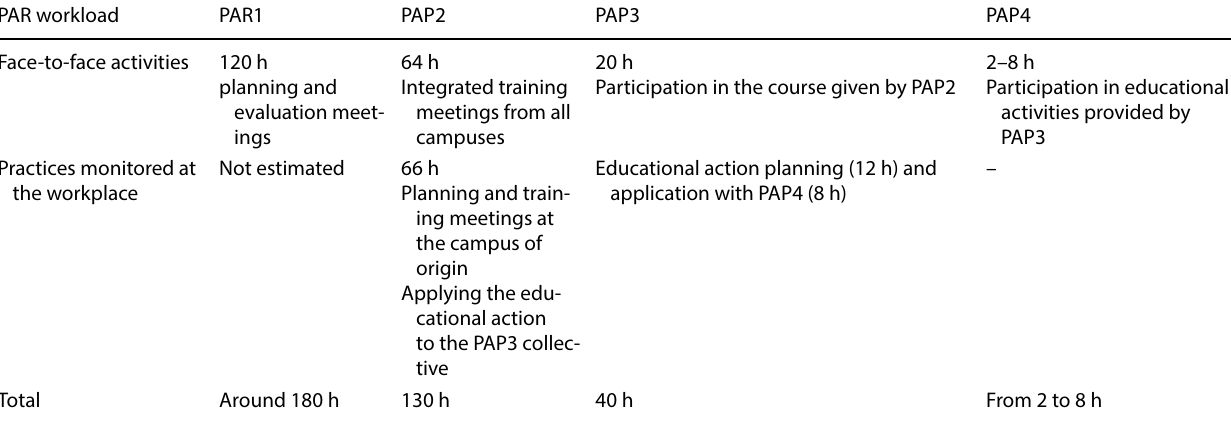
Table 2 PAP training workload and